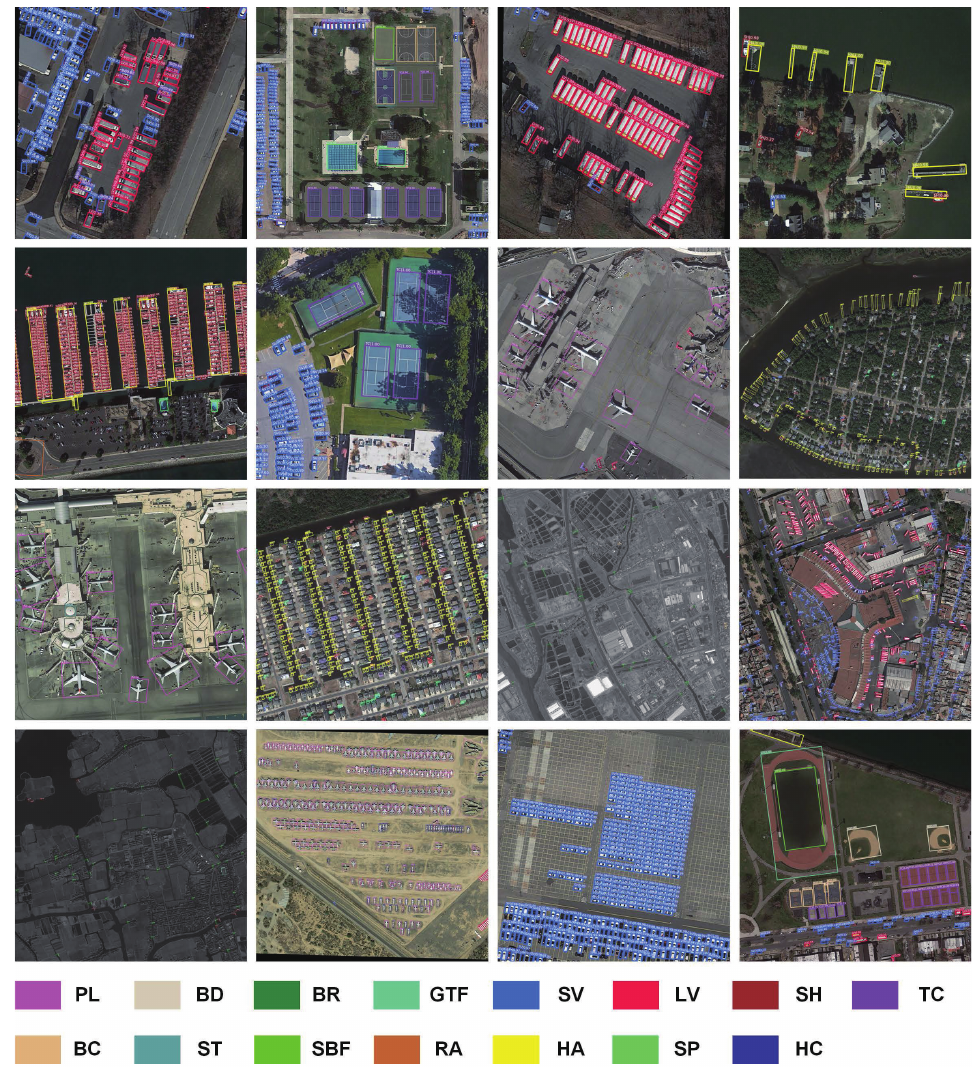
Figure 7. Depictions of the detection results on the DOTA dataset test set. We use bounding boxes of different colors to represent different